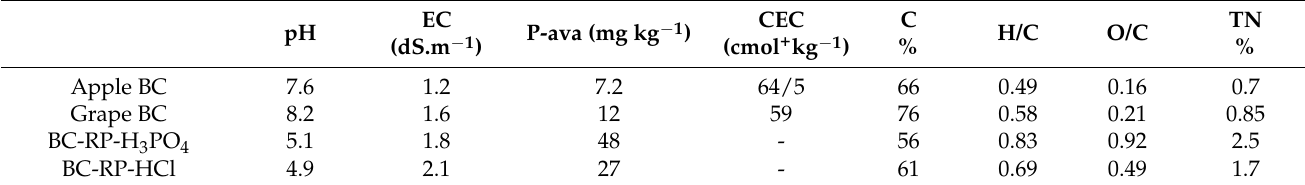
Table 1. Physical and chemical properties of biochars (BC).